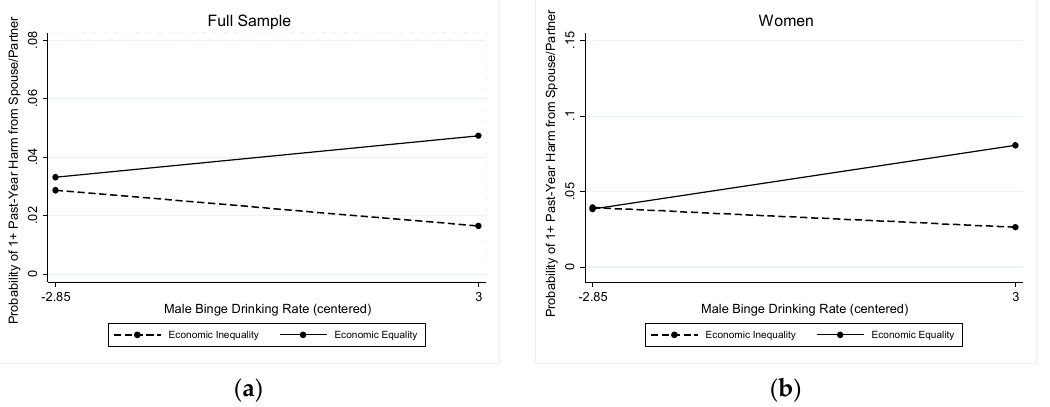
Figure 4. Interaction between male binge drinking rate and economic equality in relation to spouse-perpetrated harms ( a ) in the full sample (left panel); and ( b ) for women (right panel).